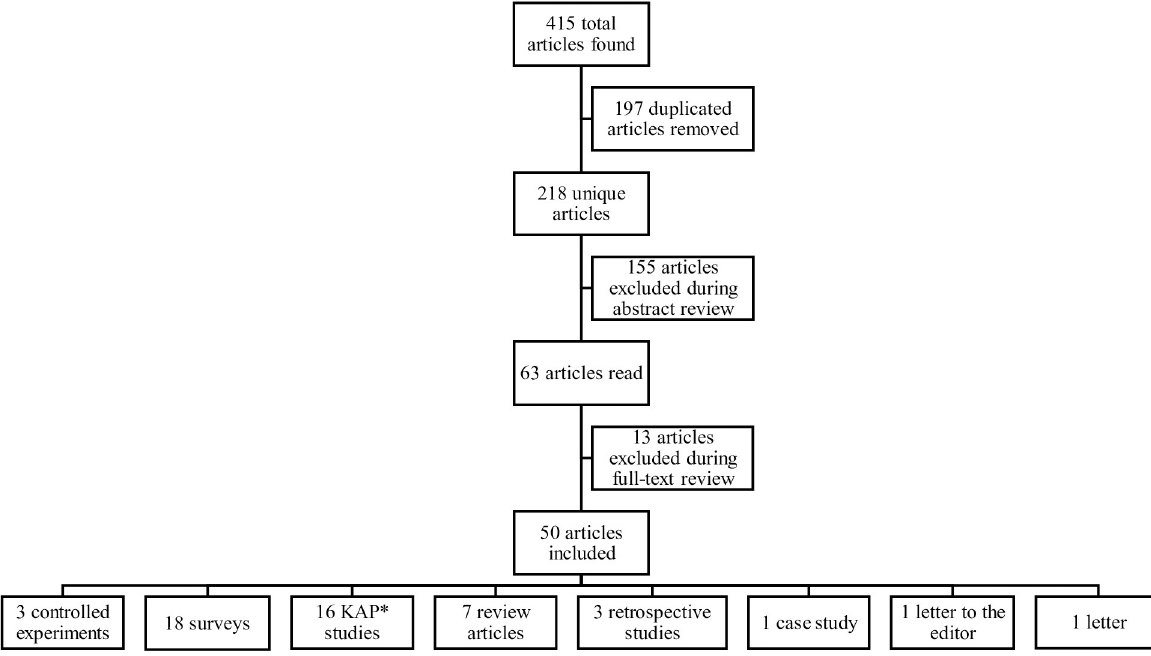
Fig 1. Results of literature search for articles pertaining to traditional medicines for treating rabies exposures, 1950–2021. From the 415 total articles found in the literature search, 197 articles were duplicate articles, 155 were excluded after reviewing the abstract, and 13 articles were excluded after full-text review. Fifty articles were included in this literature review. � KAP is knowledge, attitude, and practices.